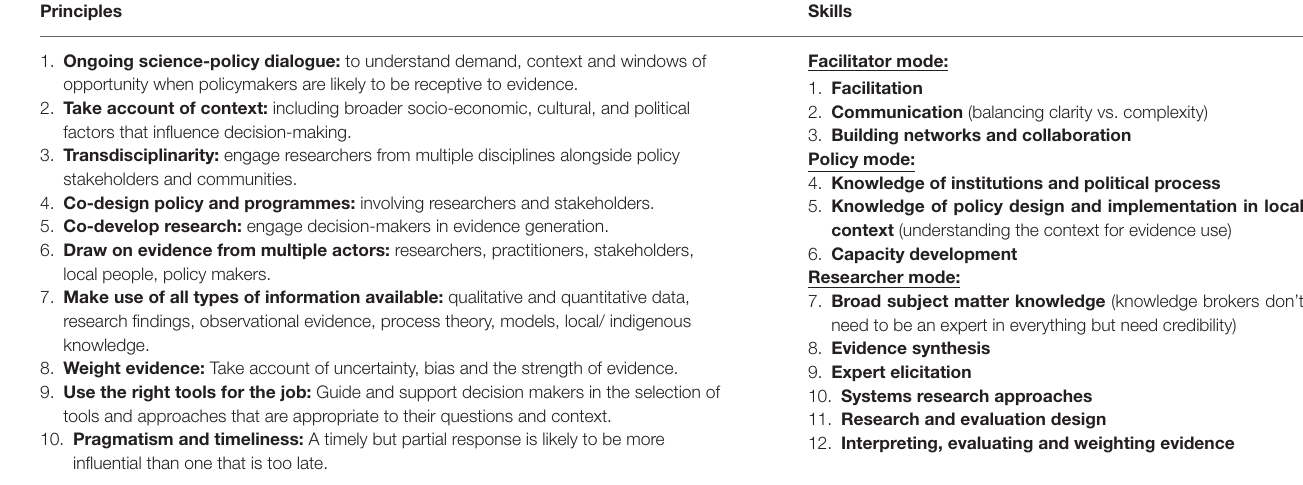
TABLE 4 | Ten proposed principles for knowledge brokering in integrated landscape management and 12 key skill-sets for knowledge brokers.